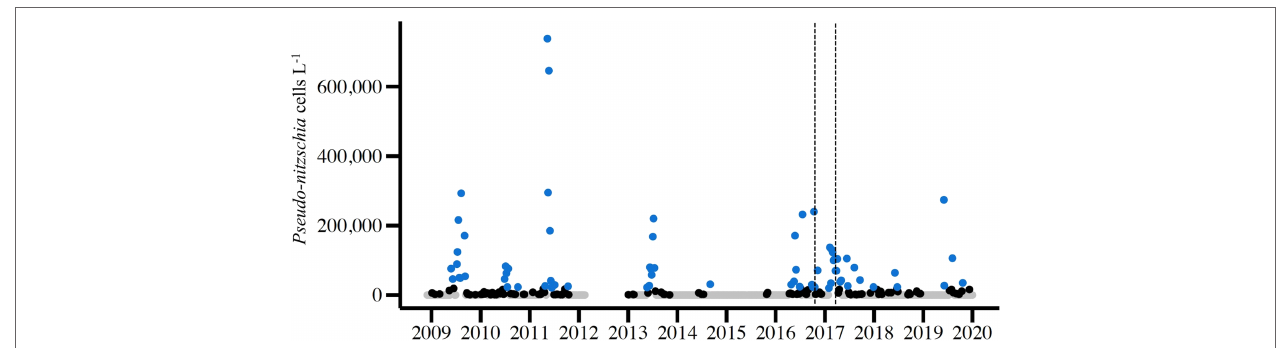
FIGURE 2 | Abundance of live Pseudo-nitzschia spp. cells from light microscopy counts of weekly NBPTS surface seawater samples spanning Dec 2008 – Dec 2019 (n=523). The NBPTS paused during Mar 2012 – Dec 2012, so no cell counts were collected. Blue points represent Pseudo-nitzschia abundance that surpassed the RI Department of Environmental Management (DEM) HAB abundance threshold of 20,000 cells per liter, while black points are non-zero abundances below the threshold and gray points are zero counts. Dotted lines denote the 2016 precautionary shellfish closure (Oct 7–30) and 2017 closure (Mar